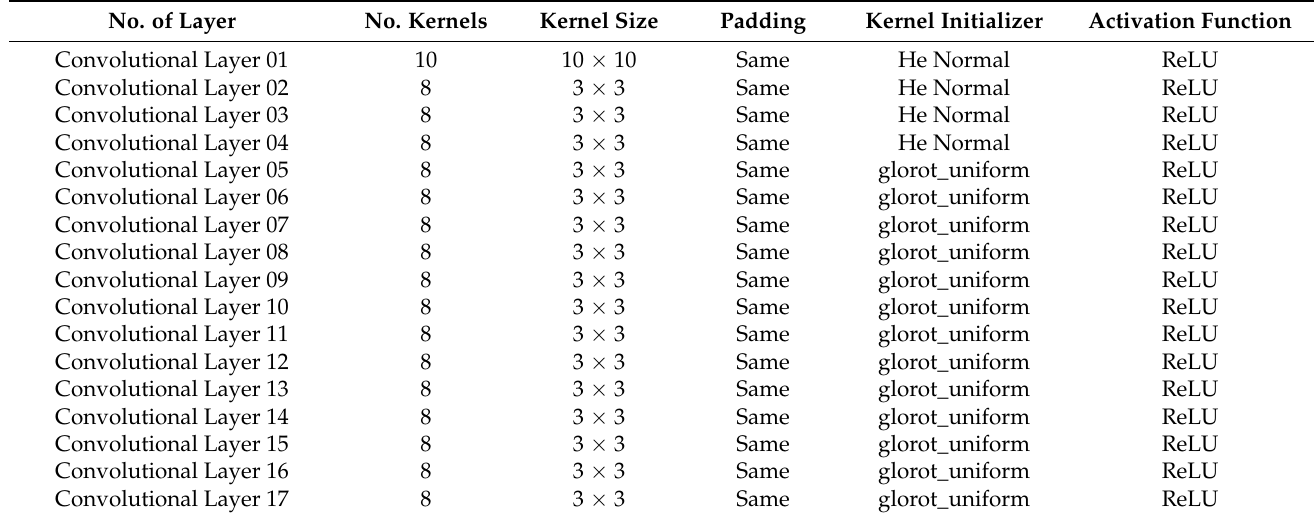
Table 2. CNN architecture for the structural response prediction method.